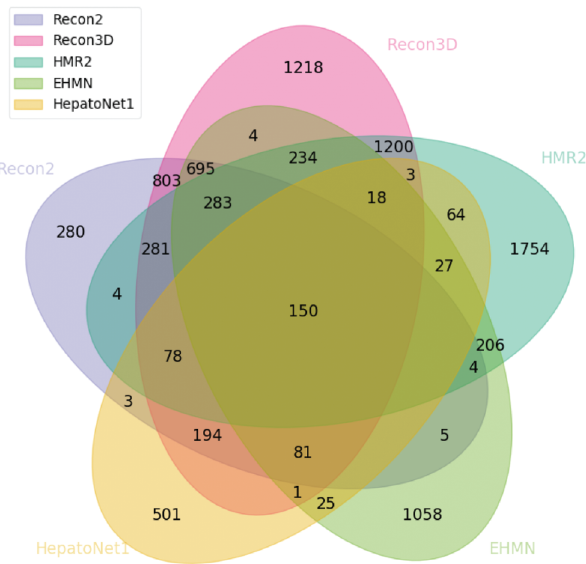
Figure 9: Venn diagram highlighting the number of reaction clusters integrated between the integrated models in both Recon2 and